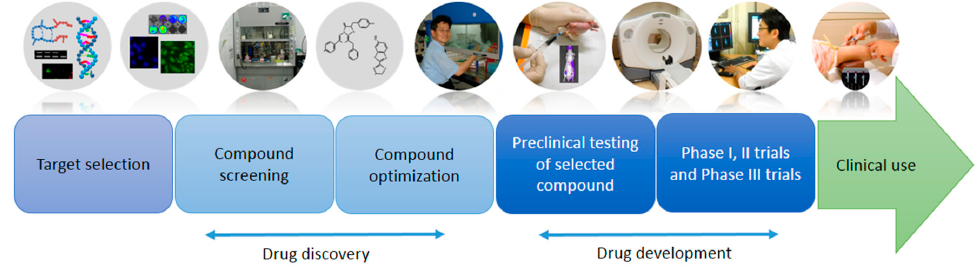
Figure 1. Processes in drug discovery and development. Although many drug candidates are evaluated in preclinical studies, very few compounds proceed to clinical trials and about one compound receives approval for administration and use in clinics. The selection of promising drug candidates in the early phase is critical for successful drug development. Molecular imaging contributes at various stages of the drug discovery and development processes.